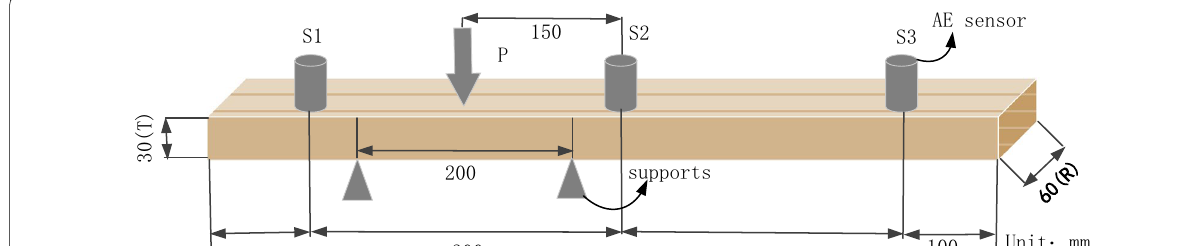
Fig. 1 Experimental structure diagram